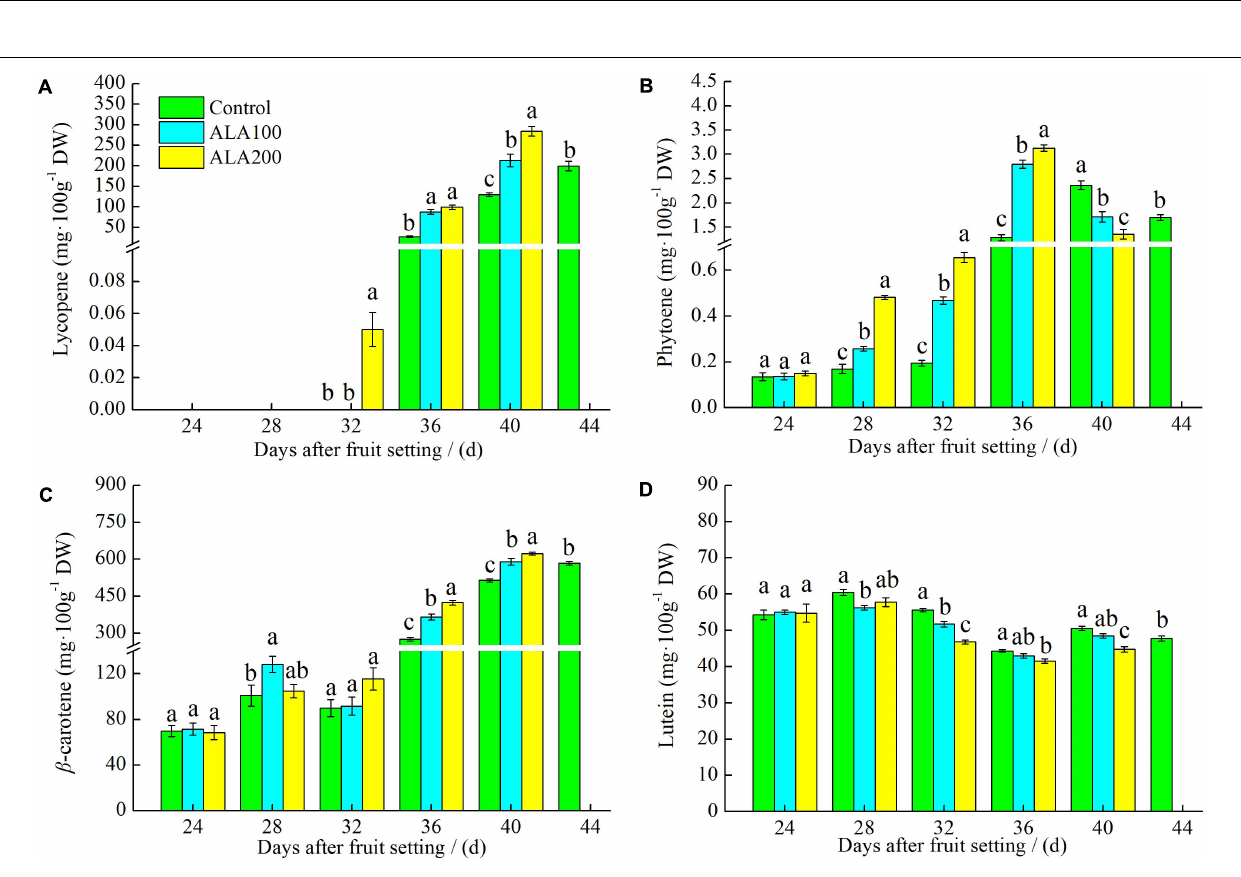
Frontiers in Plant Science |